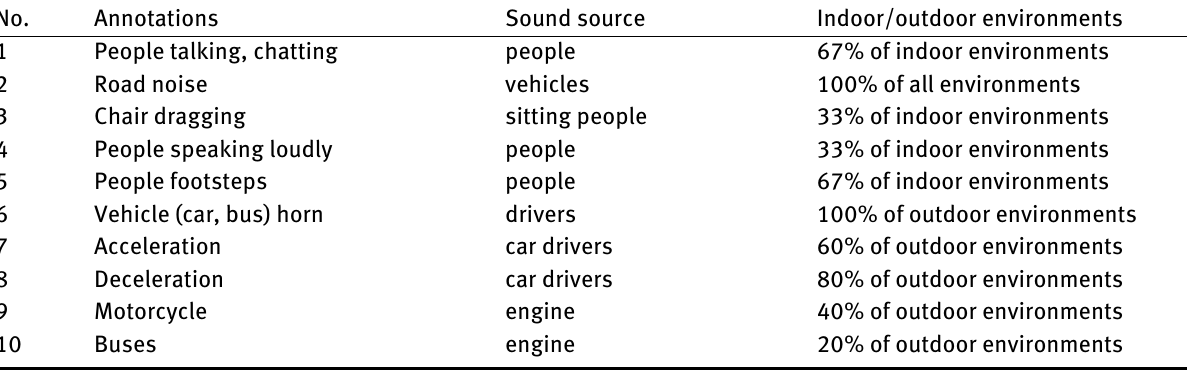
Table 2: Annotations and sound sources observed in indoor and outdoor environment locations. There were three noise level measurement locations in indoor environments as follows: one location in a library, one location in a healthcare facility and one location in a classroom. There were five noise level measurement locations in five crossroads, outdoor environments.